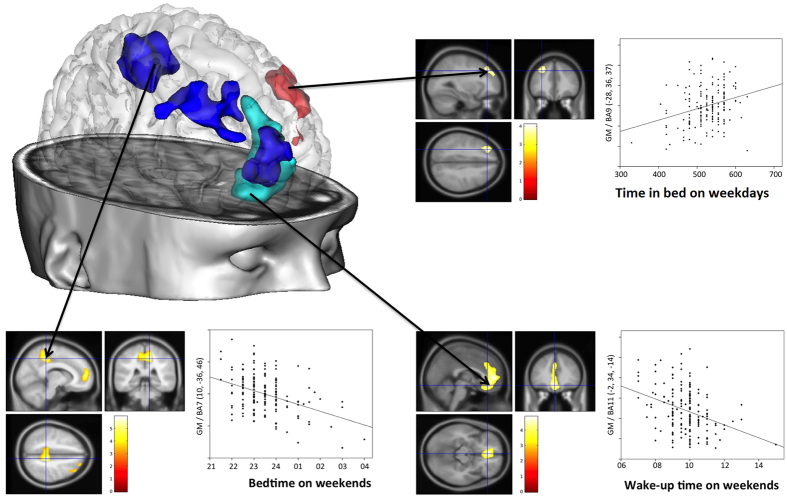
Brain regions where grey matter volumes correlated with sleep habits.Red colour and top right panel illustrate the DLPFC regions where GMV was correlated with time in bed on weekdays; light blue colour and bottom right panel illustrate the medial prefrontal and anterior cingulate regions where GMV correlated negatively with wake-up time on weekends; dark blue colour and bottom left panel illustrate the DLPFC, anterior cingulate and precuneus regions where GMV was negatively correlated with bedtime on weekends. All images are presented with height threshold p < 0.001, and FWE correction for multiple spatial comparisons across the whole brain (1200 voxels). The scatter plots are presented for the voxel of maximal statistical significance; the solid line represents the linear regression line. GMV is expressed in arbitrary units. BA = Brodmann area.